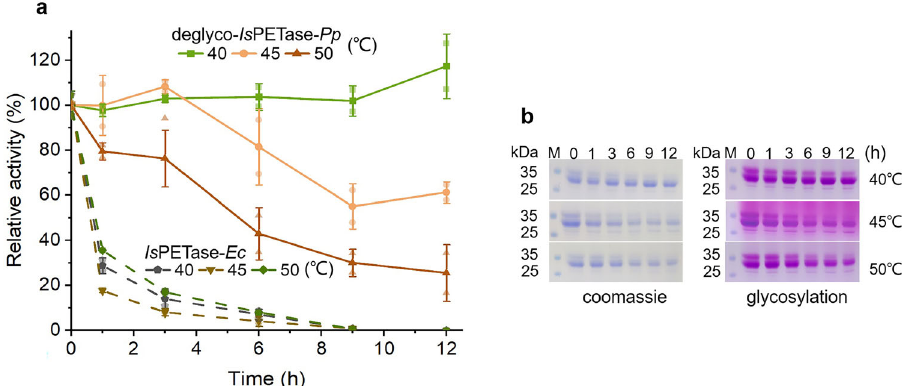
Fig. 4 The thermostability of partial-deglyco Is PETase- Pp . a The effect of thermostability partial-deglyco Is PETase- Pp at 40, 45 and 50 °C. The residual activity was determined at 30 °C. The value at 0 min was taken to 100%. Measurements were repeated three times and averaged. b SDS-PAGE to analyze the degradation of partial-deglyco Is PETase- Pp . Data are presented as mean Table 1 The speci fi c activity of the recombinant Is PETase. Enzyme